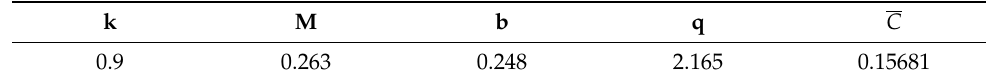
Table 6. Calculation parameters of the modified W-H method.